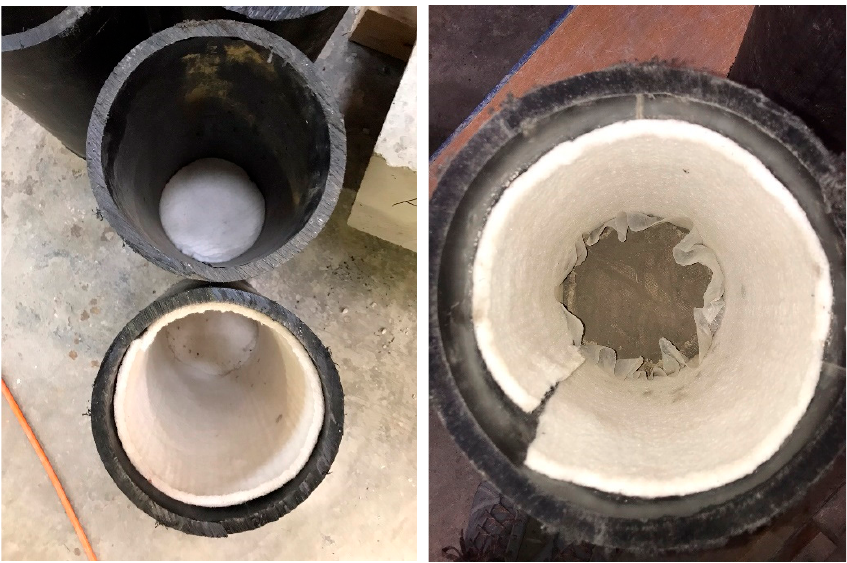
Figure 3. Establishment of the inner surface and the prepared specimen without ballast particles. The Concrete Canvas had to be hydrated, but first, an initial computed tomography (CT) recording was required, which showed the initial state. Thus, there was no chance to hydrate the CC separately, so the CC was hydrated through the stone particles. According to the instructions from [32], the necessary amount of water is 9.5 L per square meter. Using the latter value as a reference, we calculated the required amount of water proportionately. The third layer was the ballast crushed stone. The ballast material was in accordance with the MSZ EN standard [45], which is suitable for MSZ EN 13450. The standard grain size was 31.5/50 mm. LA RB was max. 13%, and the Micro-Deval Abrasion (M DE RB) was max.